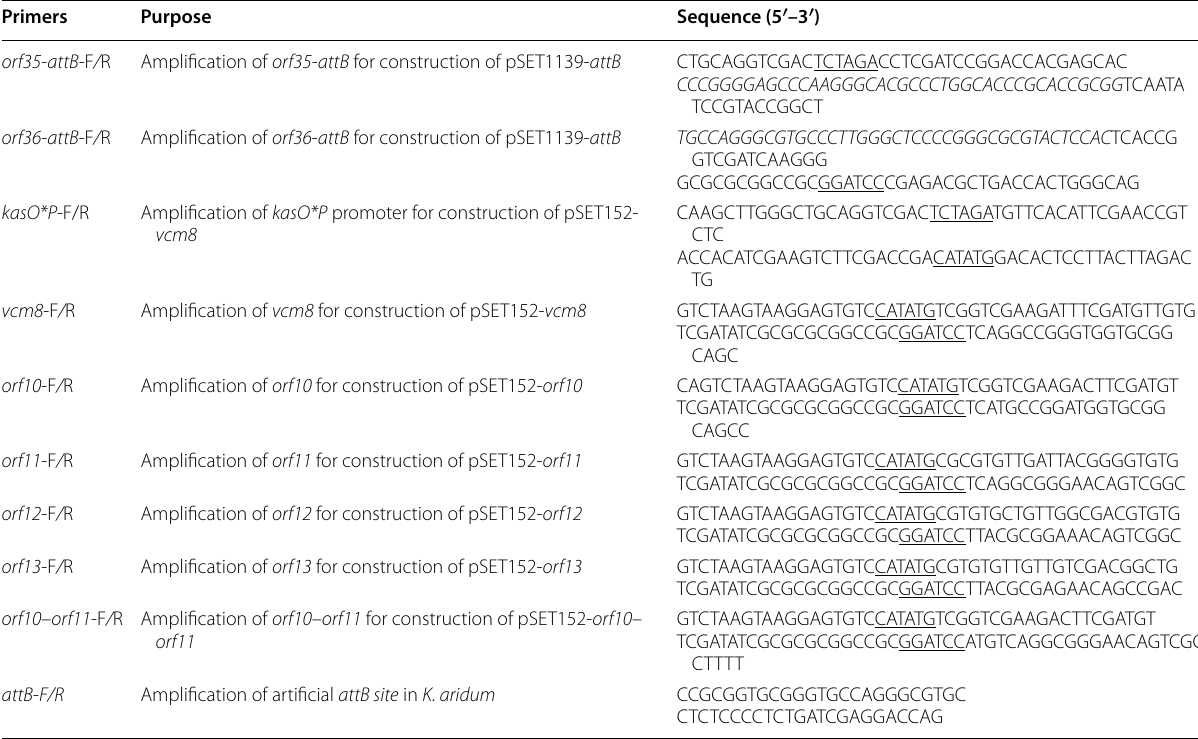
Table 2 Primers used in this